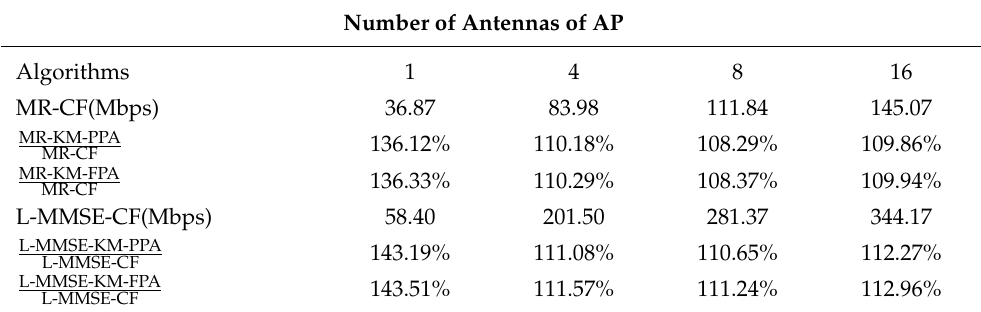
Table 5. The sum rate of IoTDs; APs equipped with different numbers of antennas ( L = 100 and K =